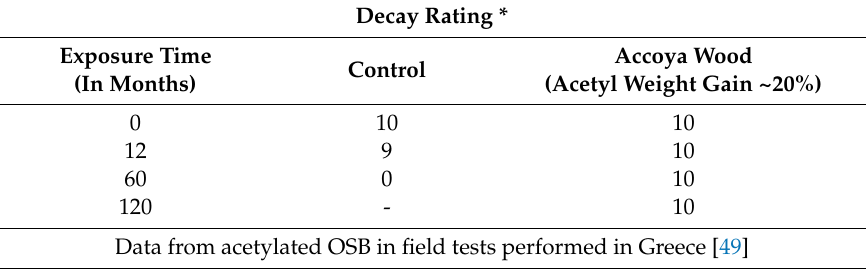
Table 1. Decay rating of acetylated wood in field tests.